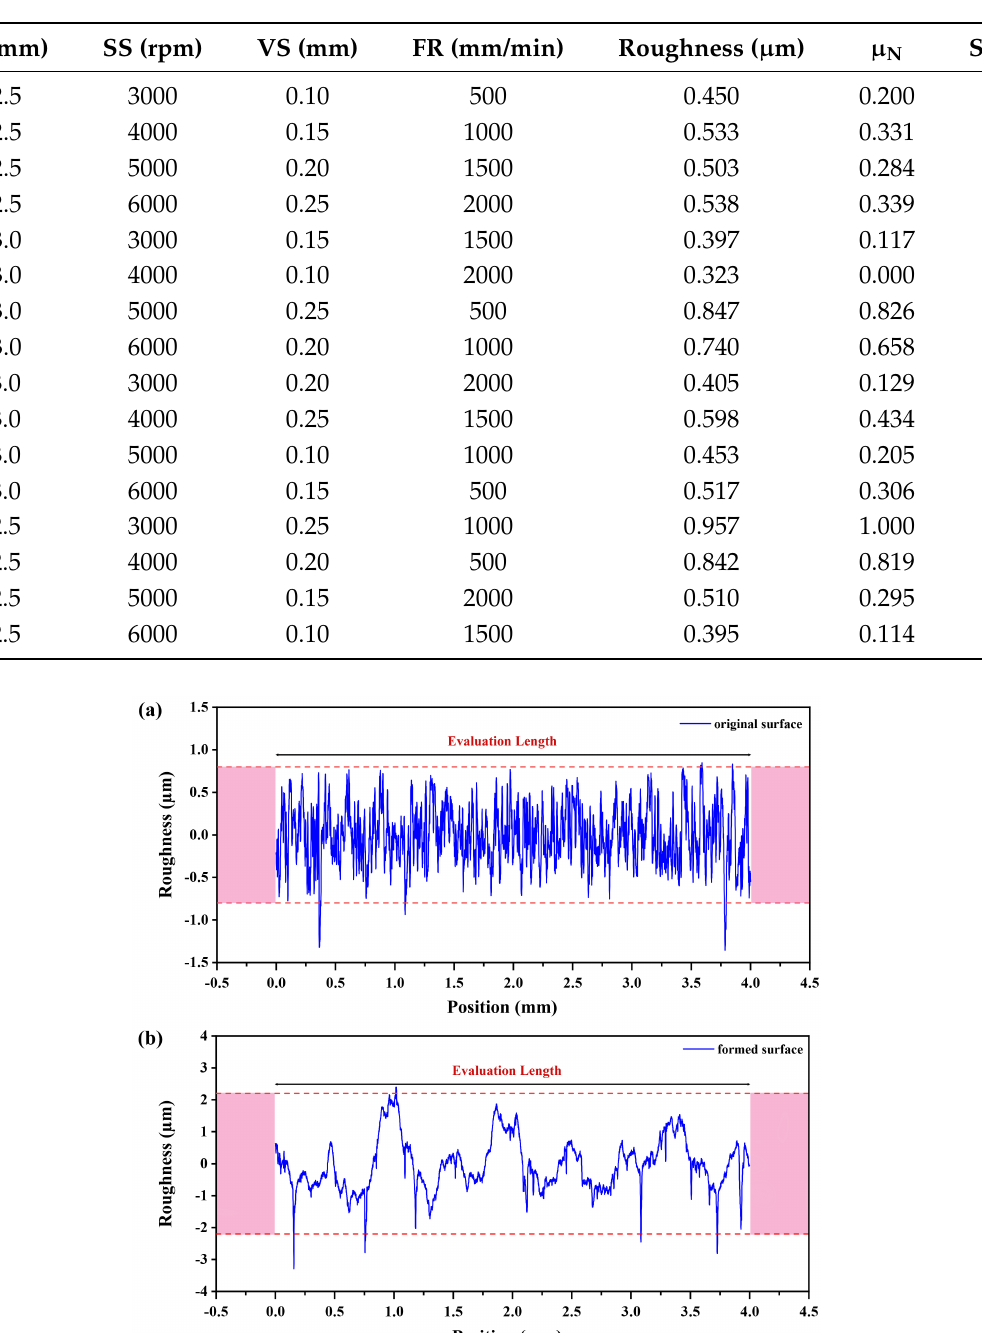
Table 2. Experimental design from Taguchi L16 orthogonal array.